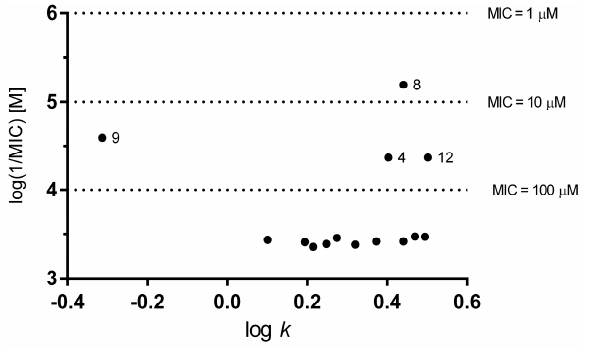
Figure 2. Dependency of antimycobacterial activity (1/MIC) on experimental parameter of lipophilicity log k .